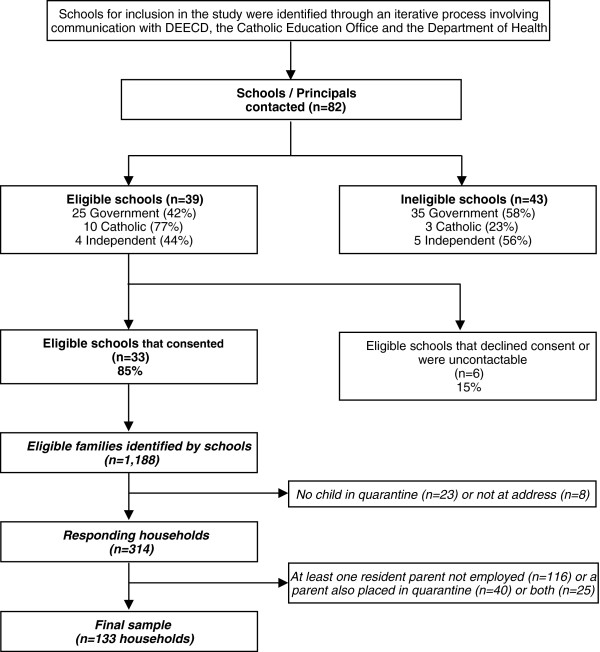
Recruitment of sample of parents whose school children were recommended to go into home quarantine (May 22nd until June 2nd, 2009), and restriction of final sample for this analysis to households in which all resident parents were employed during the quarantine period and in which no parent had been asked to stay in voluntary home quarantine.